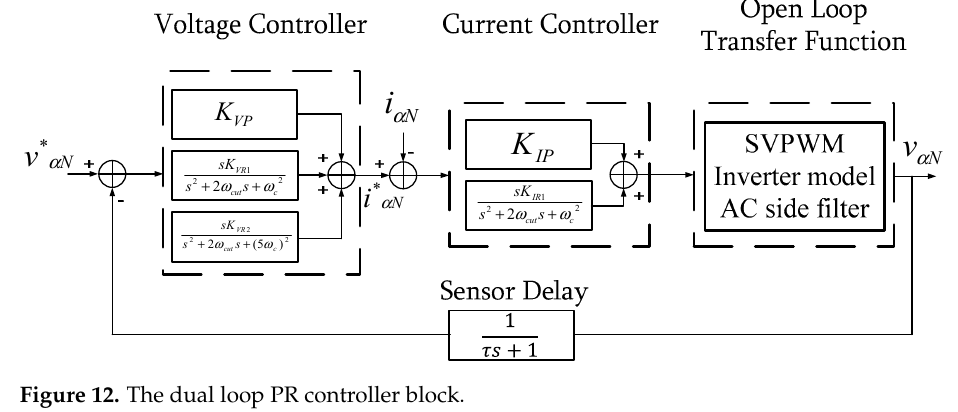
Figure 12. The dual loop PR controller block.